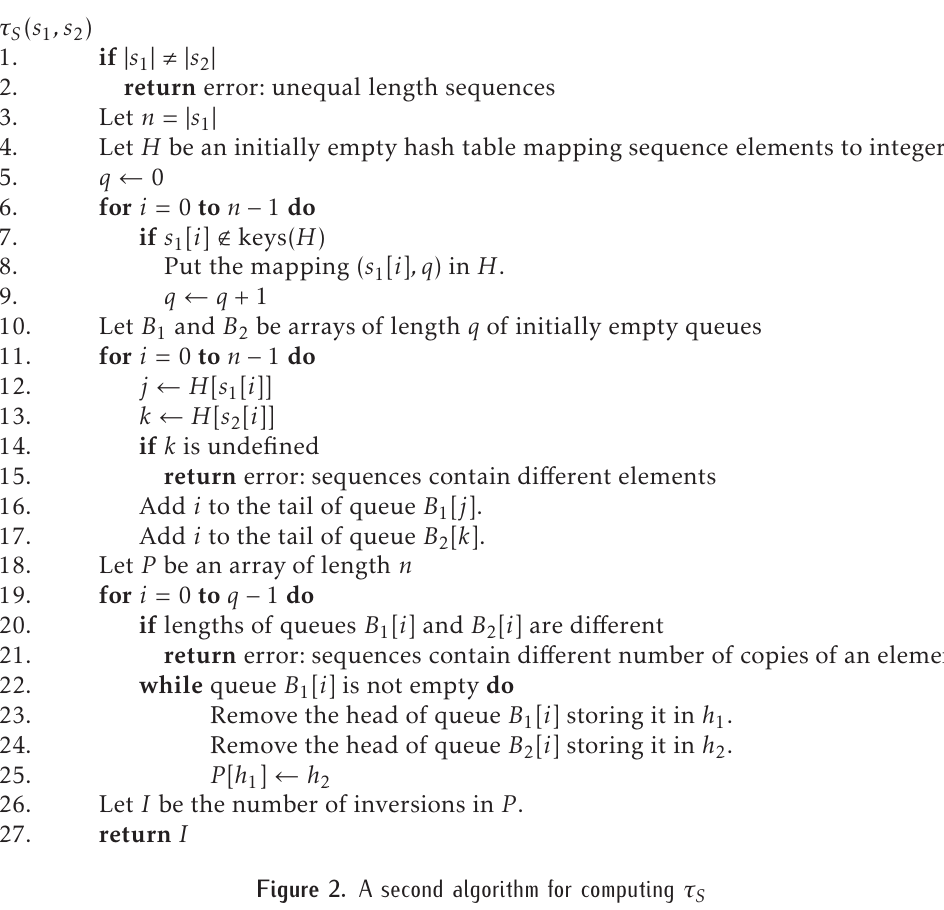
Figure 2. A second algorithm for computing τ